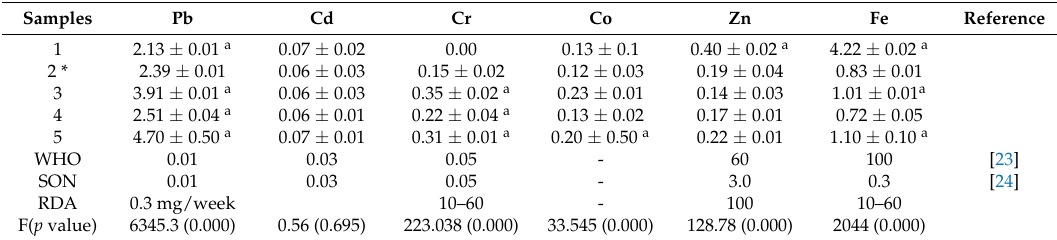
Table 3. Heavy metal content of the alcoholic beverages flavoured with herbal extracts (mg/L). Samples